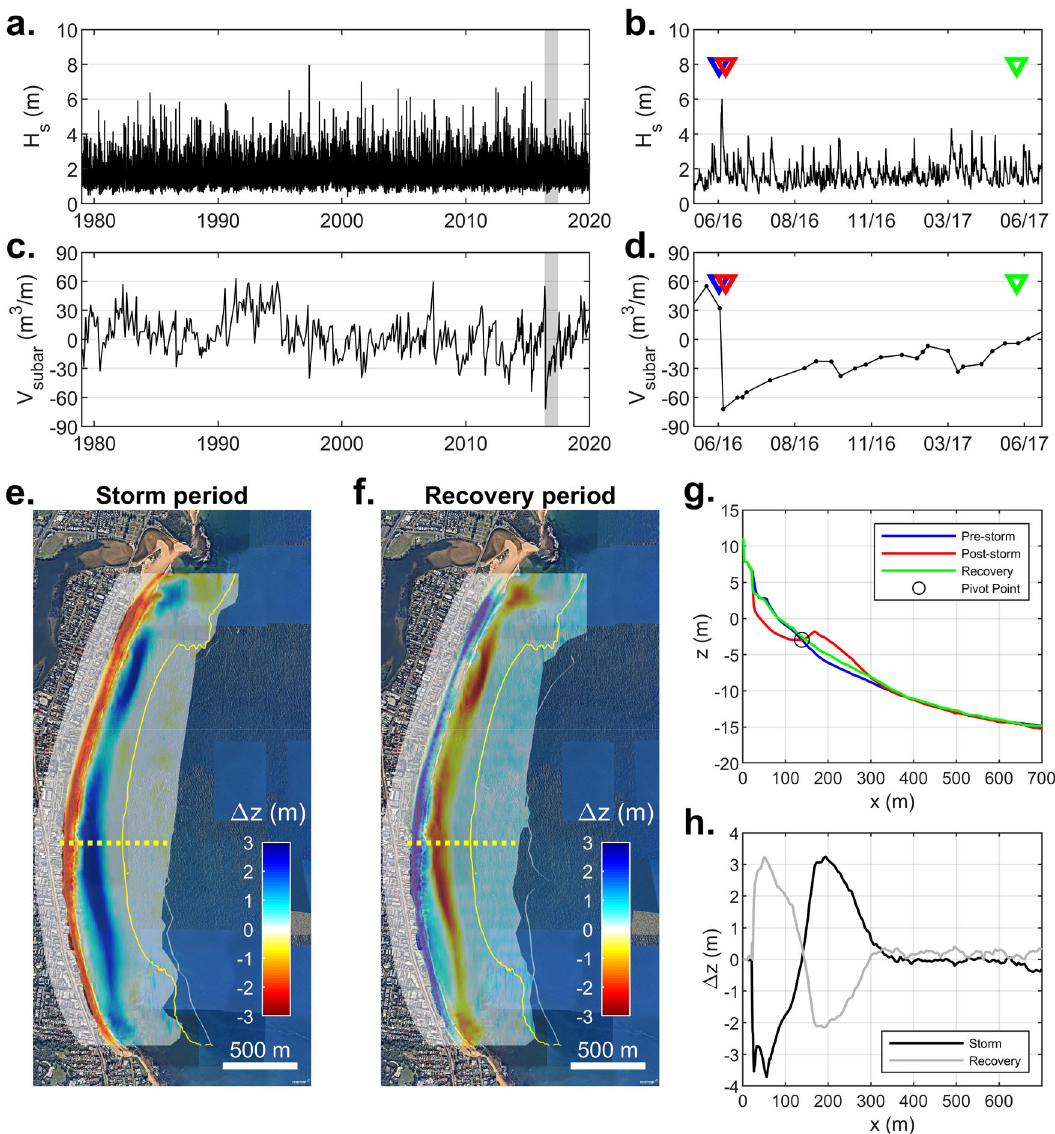
Fig. 3 Summary of wave and entire beach variability at Narrabeen Beach, Australia. a Deep-water signi fi cant wave height for Sydney (1979 – 2020); and b during the storm-recovery sequence. c Average subaerial volume change from long-term surveys (1979 – 2020); and d during the storm-recovery sequence. e Overall vertical change due to the storm period and f during the recovery period (Depth of Closure indicated by yellow solid lines). g A representative cross-shore transect indicating pre-storm, post-storm, and recovery morphology; and h the vertical change over these two periods. Shaded regions in panels a and c denote the storm-recovery sequence and triangles in b and d the timing of pre-storm (blue), post-storm (red), and recovery (green) surveys. Basemap data in ( e , f ) ©2022